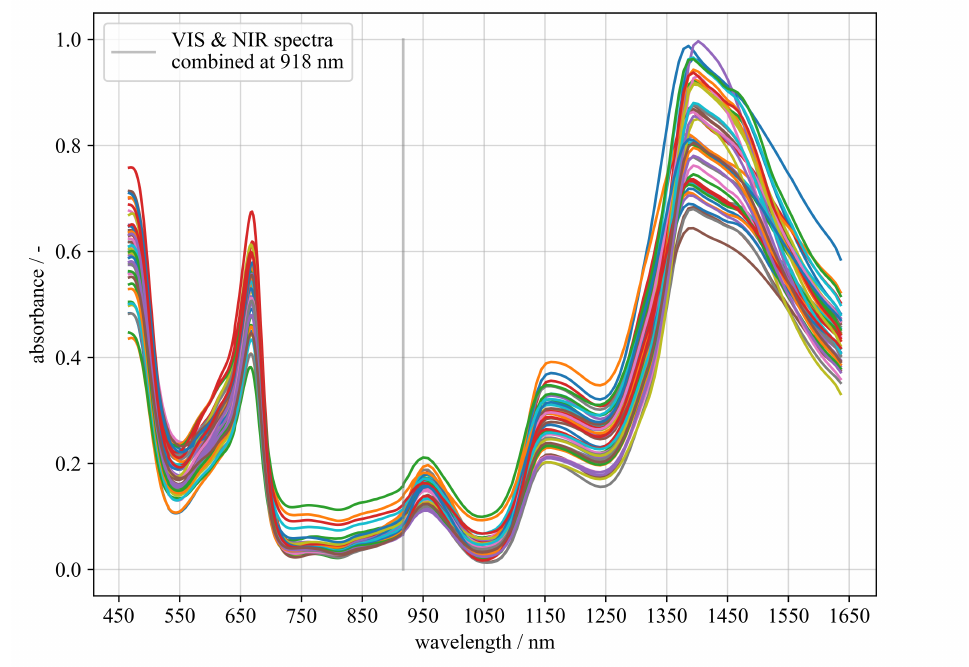
Figure 2. Preprocessed OpenVNT spectra of Vis29 and Nir22 (coloured lines), combined at 918 nm, vertical grey